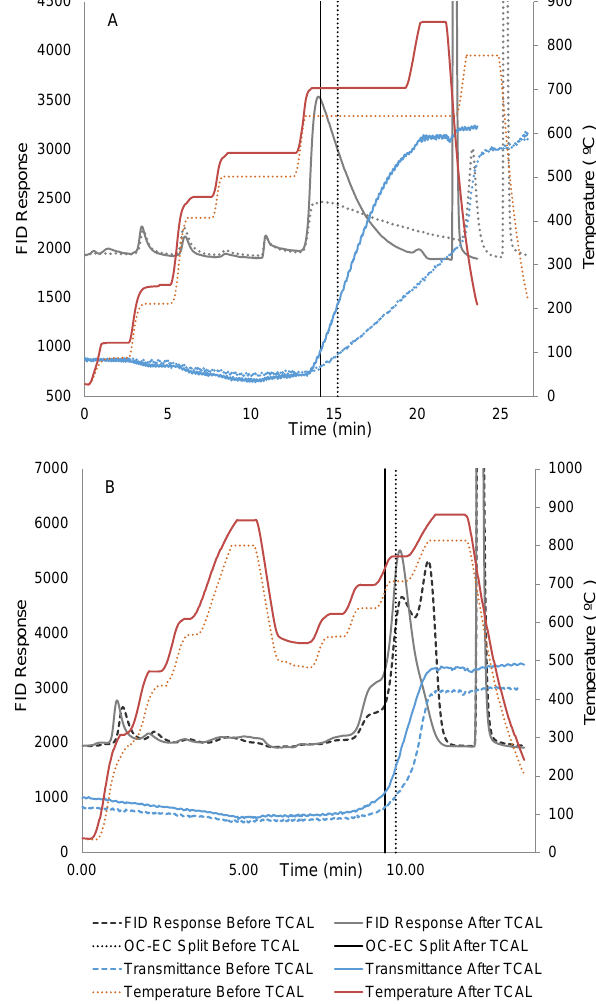
Figure 3. Typical (a) IMPROVE TOR thermogram and (b) NIOSH TOT thermogram for the same sample analyzed before and after